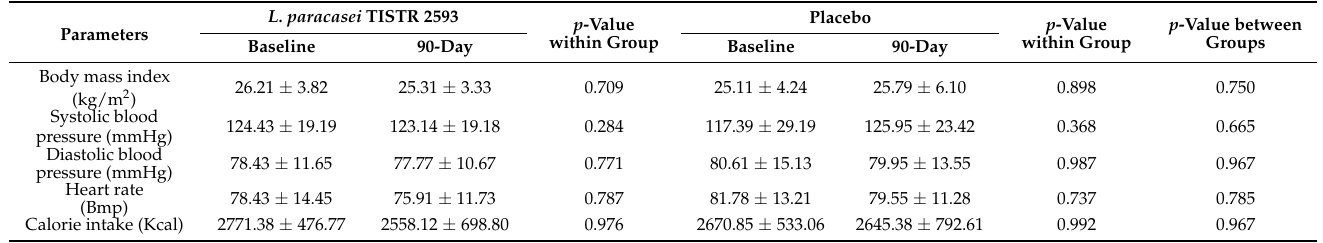
Table 1. The general characteristics of the subjects. Data were presented as ± standard